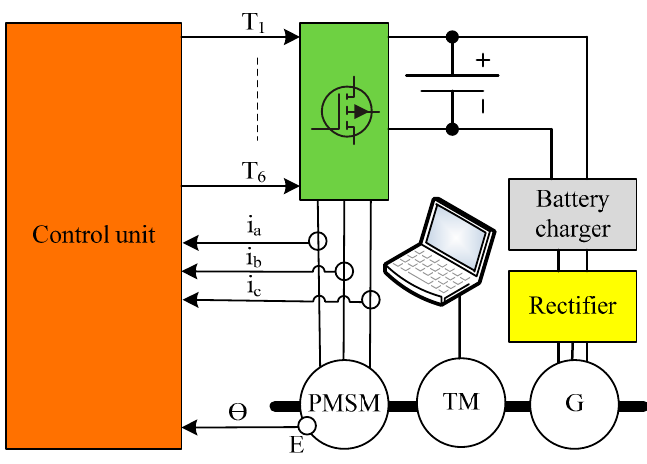
Figure 4. The laboratory setup for encoder testing of the drive with a PMSM.